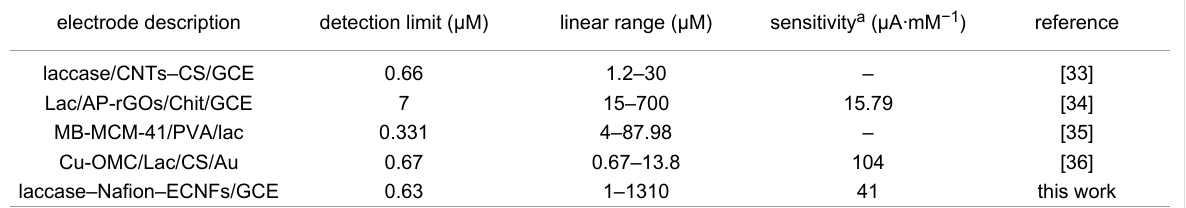
Table 1: Performance comparison of different laccase modified electrodes.